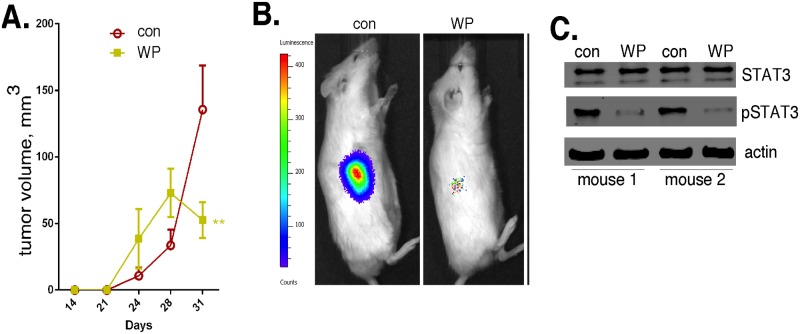
The antiglioma effects of the STAT3 inhibitor WP1066.Mice were subcutaneously injected with 1x106 luciferase-tagged Ad-GSCs, and upon initial detection of tumor, mice were treated with WP1066 (40 mg/kg) every other day. A. Tumor volume was determined with calipers (n = 5). B. Representative bioluminescence images at Day 31. C. Lysates of tumor tissue at one week following WP1066 treatment were immunoblotted for STAT3 and phospho-STAT3 as indicated. Error bars, S.D. * p < 0.05, ** p < 0.01, *** p < 0.001.